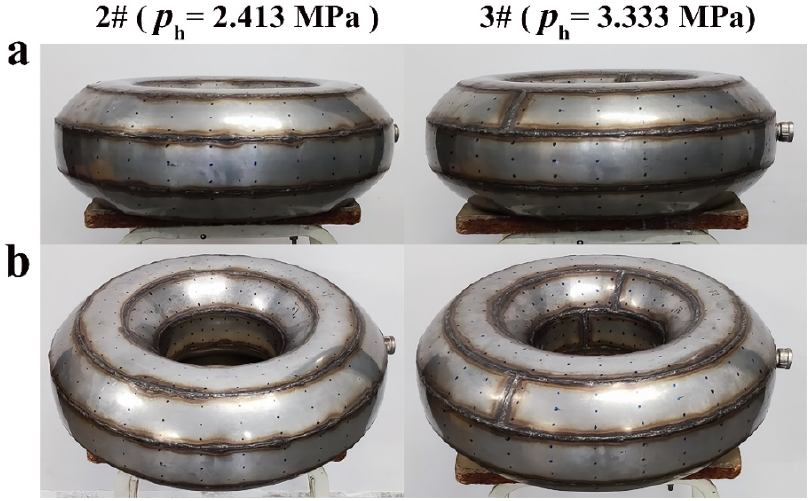
Figure 17. Photographs of two hydroformed toroids after hydroforming tests: ( a ) front view and ( b ) isometric view.